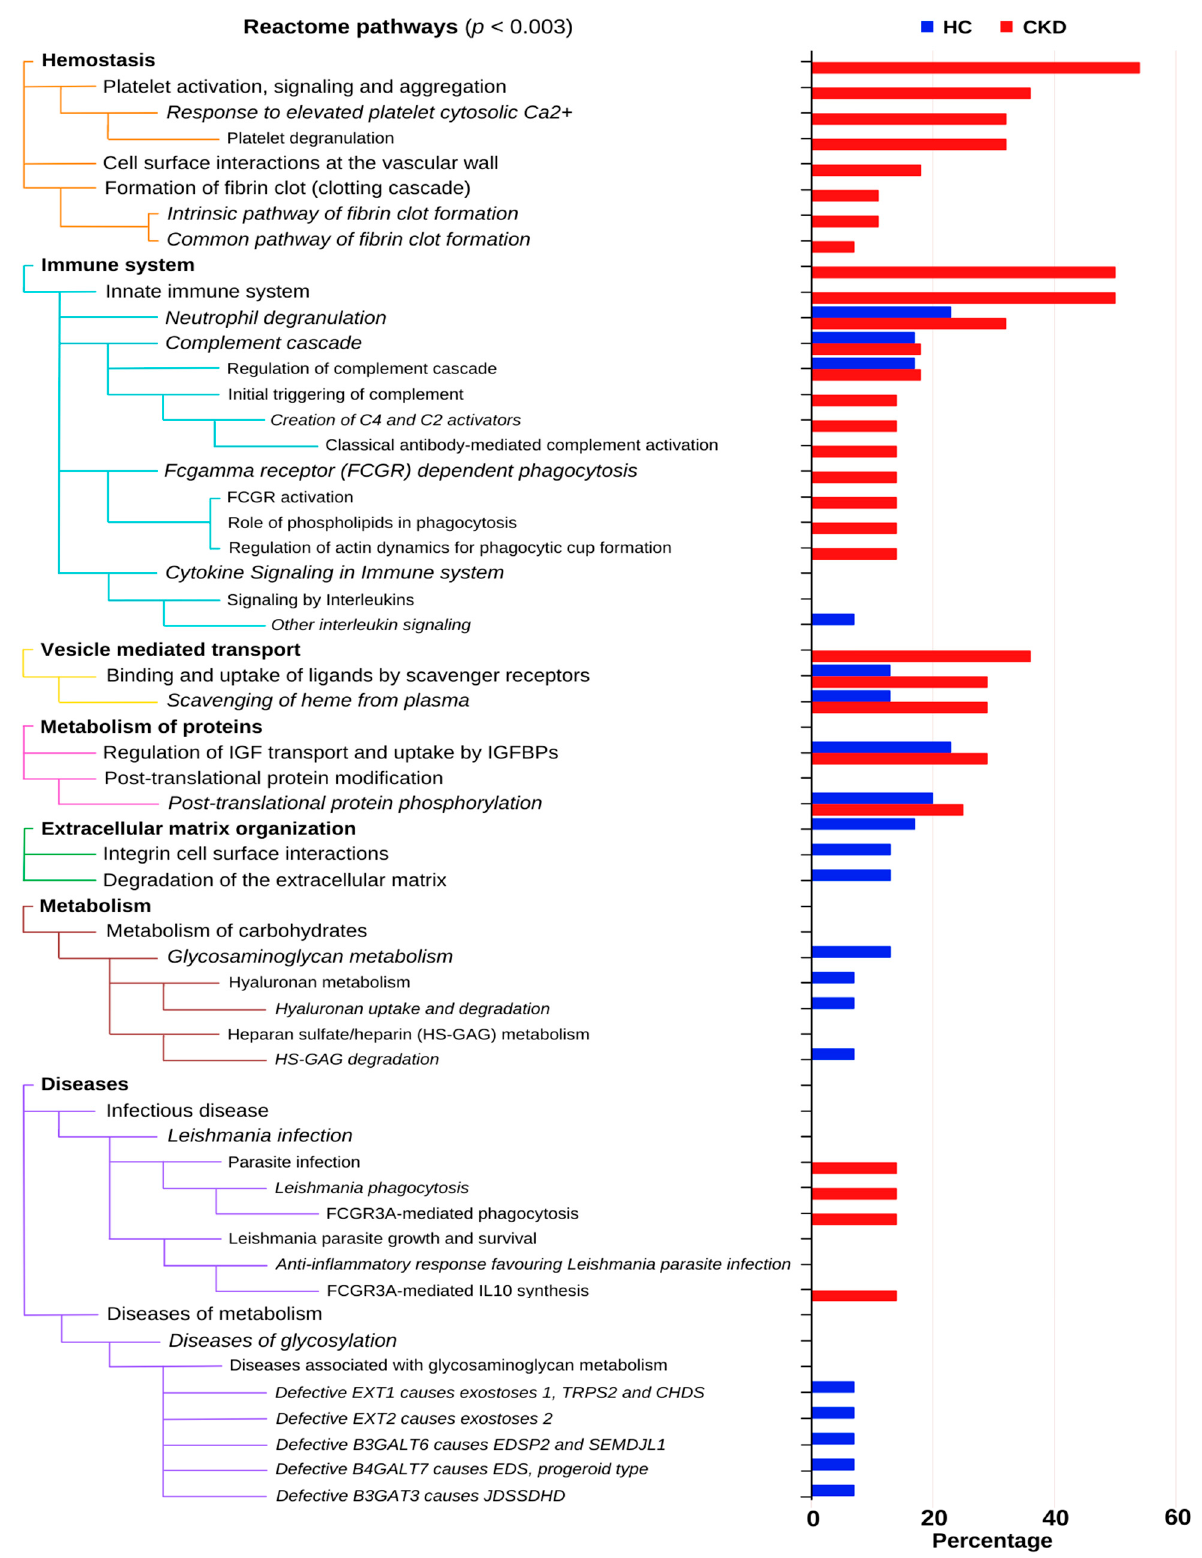
Figure 3. A comparison of highly significant pathways of the most relevant proteins in the CKD and healthy control groups ( p < 0.003). The color codes denote the different pathway groups. CKD, chronic kidney disease; HC, healthy controls; IGF, insulin-like growth factor; IGFBPs, uptake by insulin-like growth factor binding proteins.